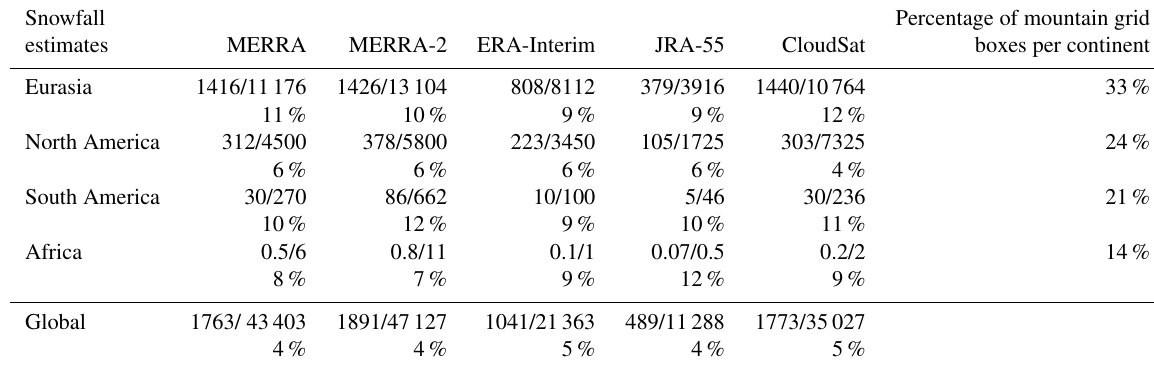
Table 1. The table summarizes the snowfall estimates of mountain and non-mountain snowfall for MERRA, MERRA-2, ERA-Interim, JRA-55 and CloudSat, for the time period 2007–2016, for Eurasia, North America, South America, Africa and globally. Global snowfall is the cumulative snow falling over all land in the world, which includes the four continents already cited plus Greenland, Australia and Antarctica. For each area and dataset, a table cell shows: the amount of mountain (top left), non-mountain snow (top right, km 3 yr − 1 ) and the contribution of mountain snow to the total amount of snow falling over a continent (bottom, %). The last column shows the percentage of grid boxes considered to be mountain by the mountain mask over each